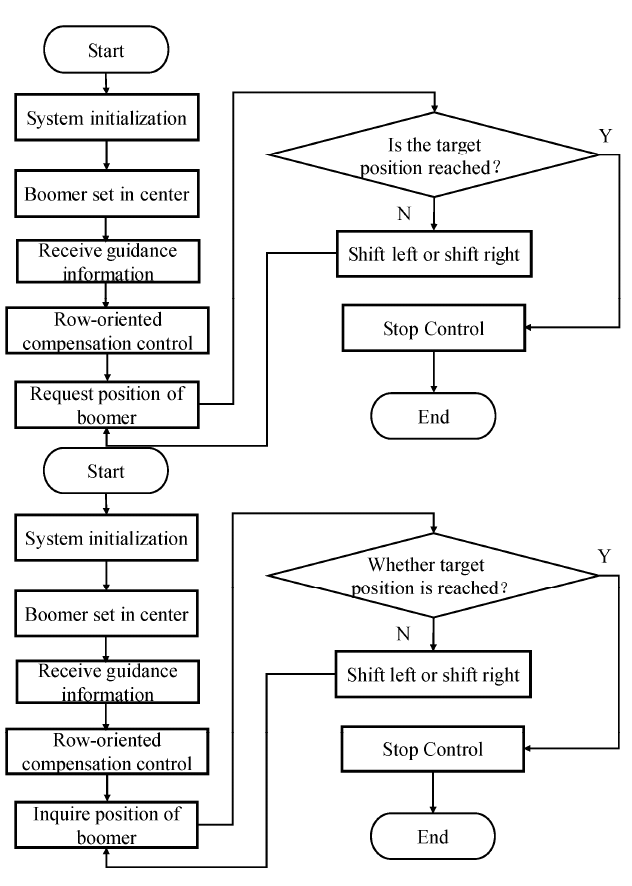
Figure 12. Flow chart of the row-orientation control algorithm.